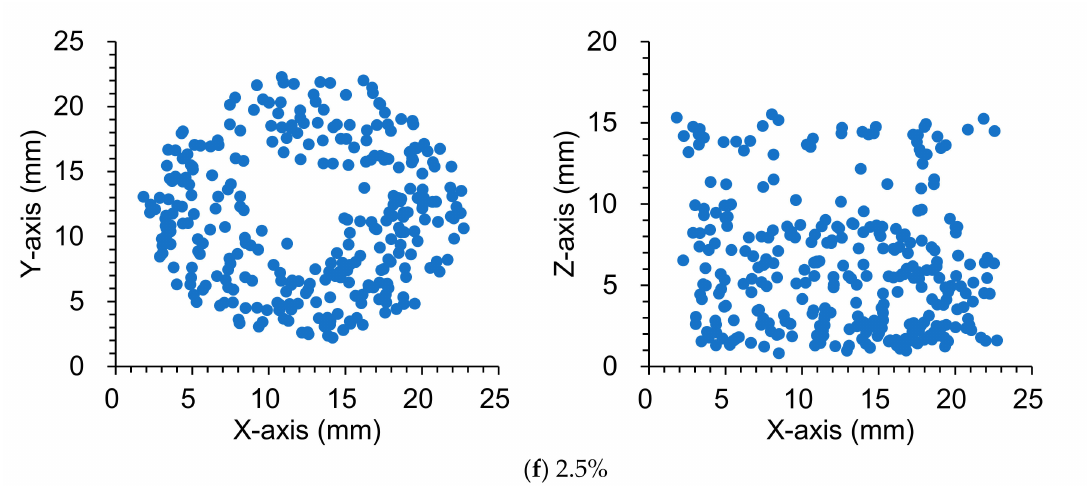
Figure 5. Distribution of the centroid of separate fibers in HPFRCC with various amount of steel fibers.